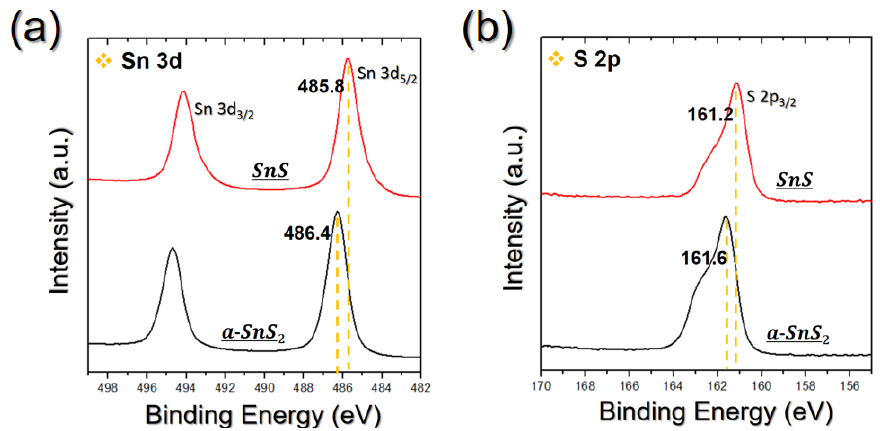
Figure 2. X-ray photoelectron spectroscopy (XPS) spectra of a-SnS 2 film and SnS film transformed from a-SnS 2 , indicating ( a ) Sn 3d and ( b ) S 2p peaks.